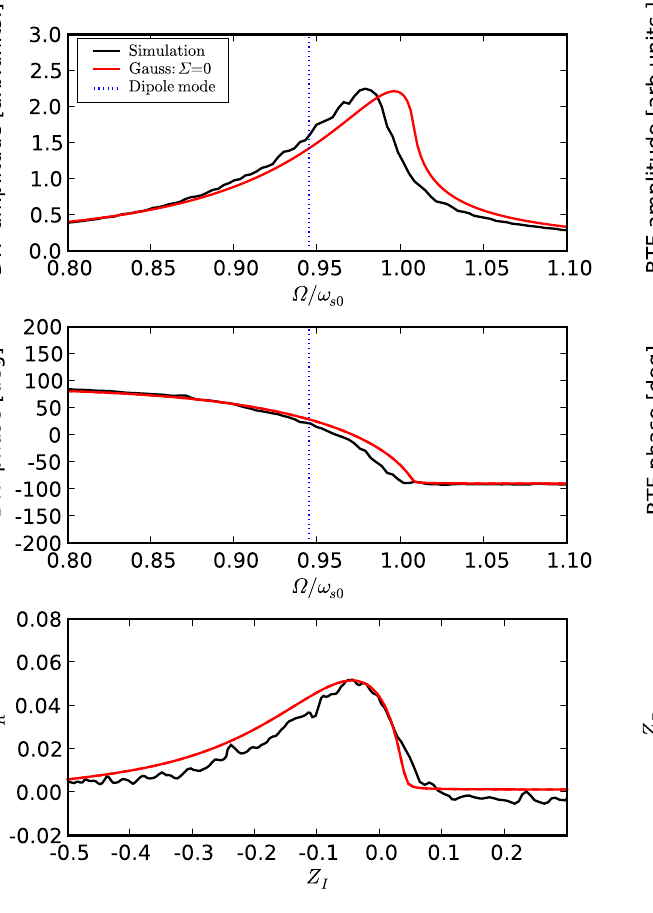
FIG. 13. (Color) CBTF amplitude (top) and phase (middle) as a FIG. 14. (Color) CBTF amplitude (top) and phase (middle) as a function of the rf modulation frequency (cid:4) for a Gaussian bunch function of the rf modulation frequency (cid:4) for a Gaussian bunch (cid:7) 60 (cid:12) , space charge (cid:7) 60 (cid:12) , space charge in a single rf bucket, bunch length (cid:1) in a single rf bucket, bunch length (cid:1) m m parameter (cid:1) (cid:7) 0 . The resulting stability boundary (bottom) as a parameter (cid:1) (cid:7) 0 : 03 . The resulting stability boundary (bottom) function of the effective impedances. The red curves show the as a function of the effective impedances. The red curves show BTF and the stability boundary obtained from the dispersion the BTF and the stability boundary obtained from the dispersion relation.